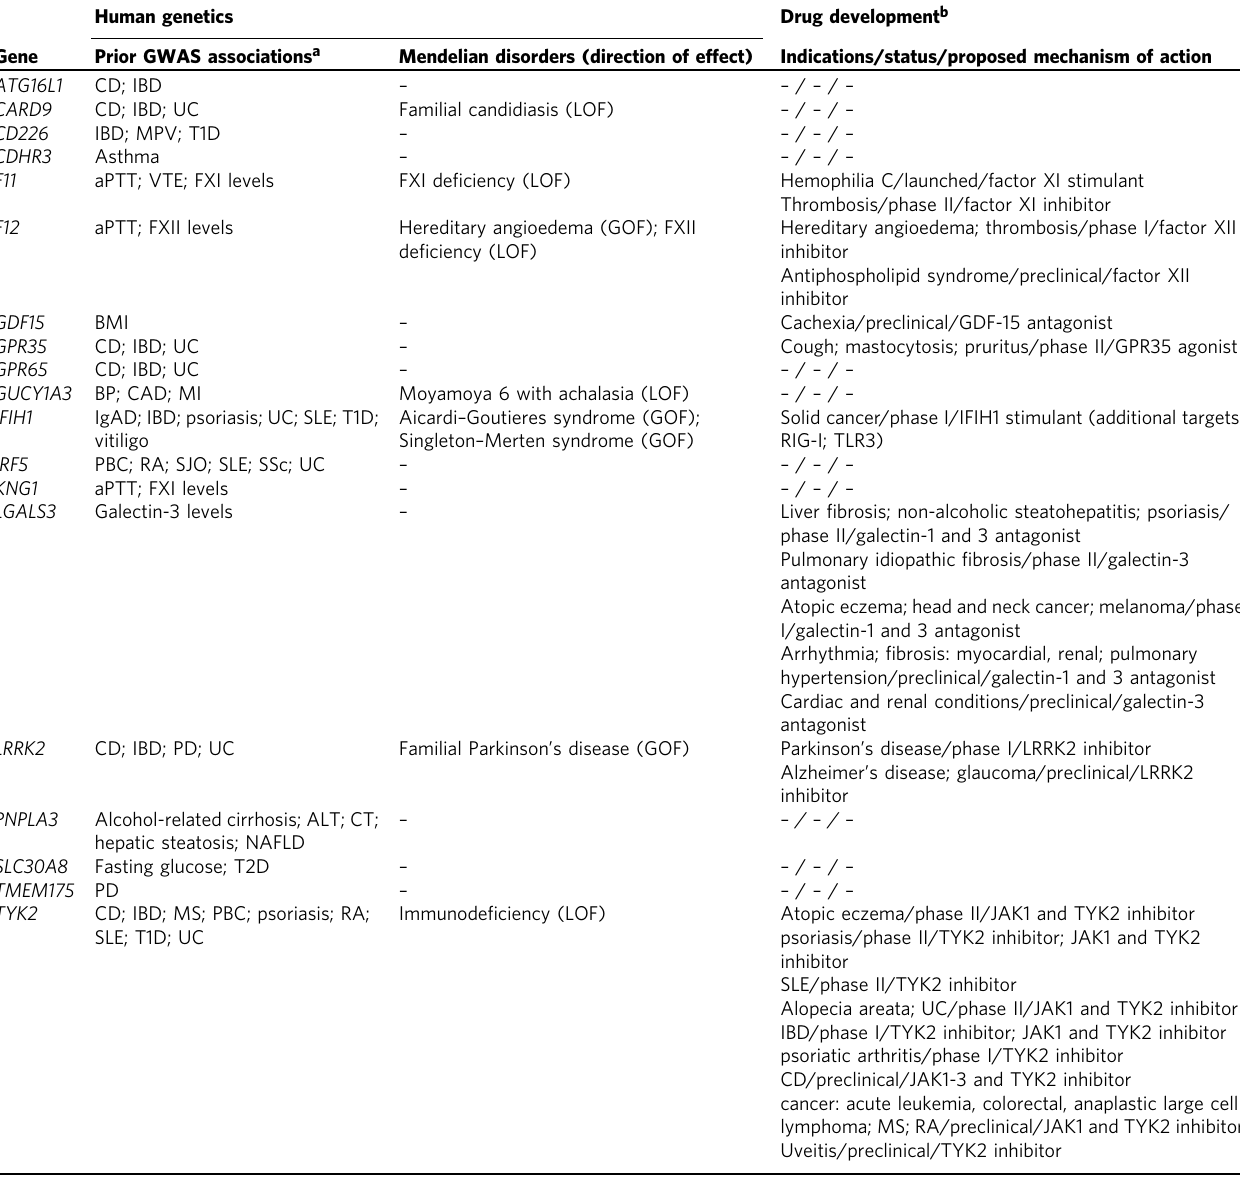
Table 1 Candidate drug targets investigated in the study Human